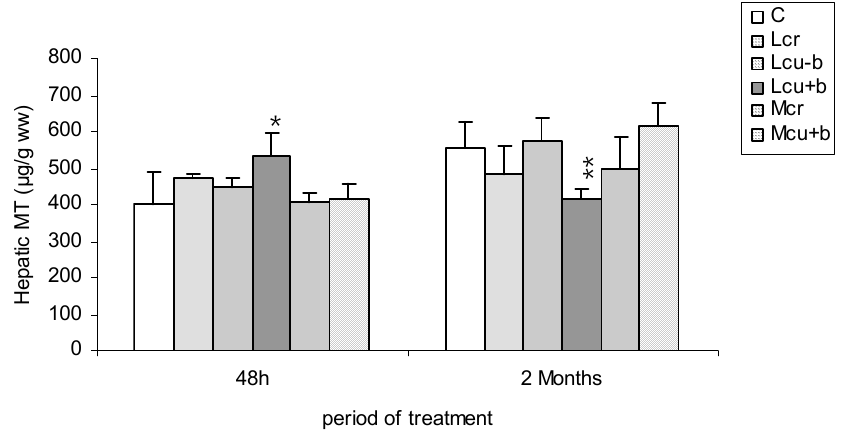
Figure 7. Metallothionein levels in the liver of control and treated rats (Lcr, Lcu-b, Lcu+b, Mcr and Mcu+b). The values are expressed as mean ± SEM (n = 6). Significant levels observed are * p ≤ 0.05 and ** p ≤ 0.01 compared with control group